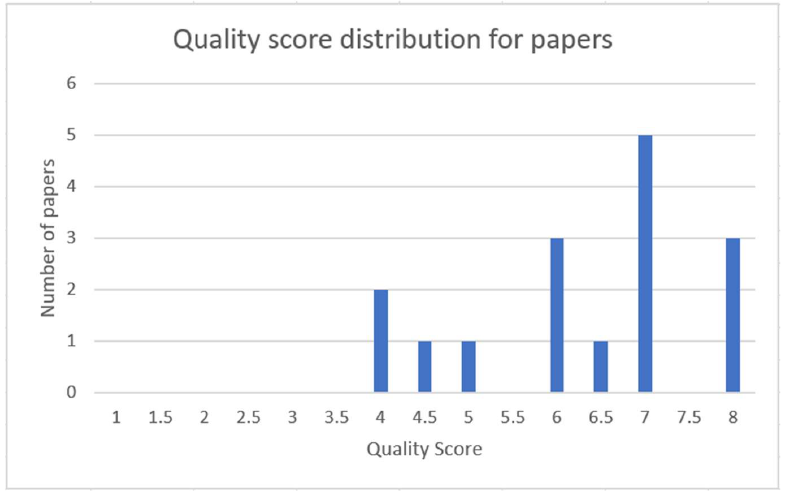
Figure 6. Distribution of the papers quality score basis.